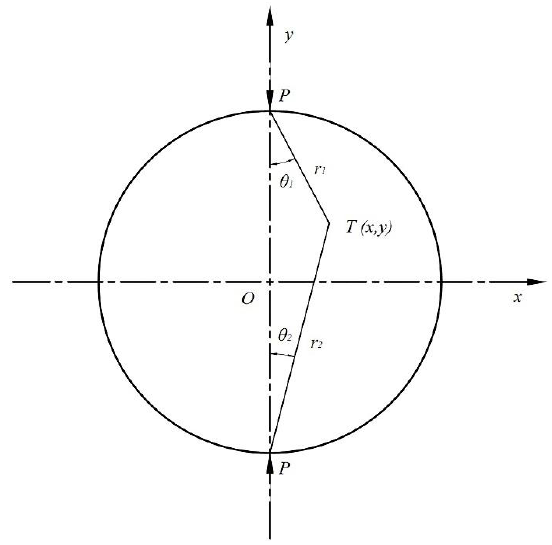
Figure 13. Stress condition of Brazilian disc splitting test.